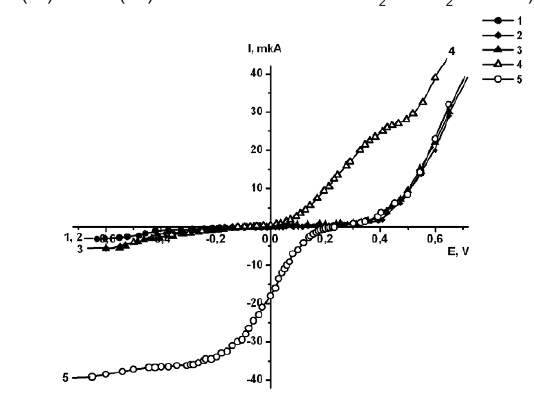
Figure 1. Voltammetric curves of: 1 - 12.5 М NaOH, 2 – 5.00×10 -3 М CrO 42- ; 3 –1.03×10 -3 М [Fe(OH)